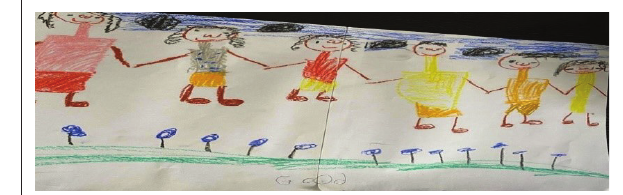
FIGURE 3: Child 3’